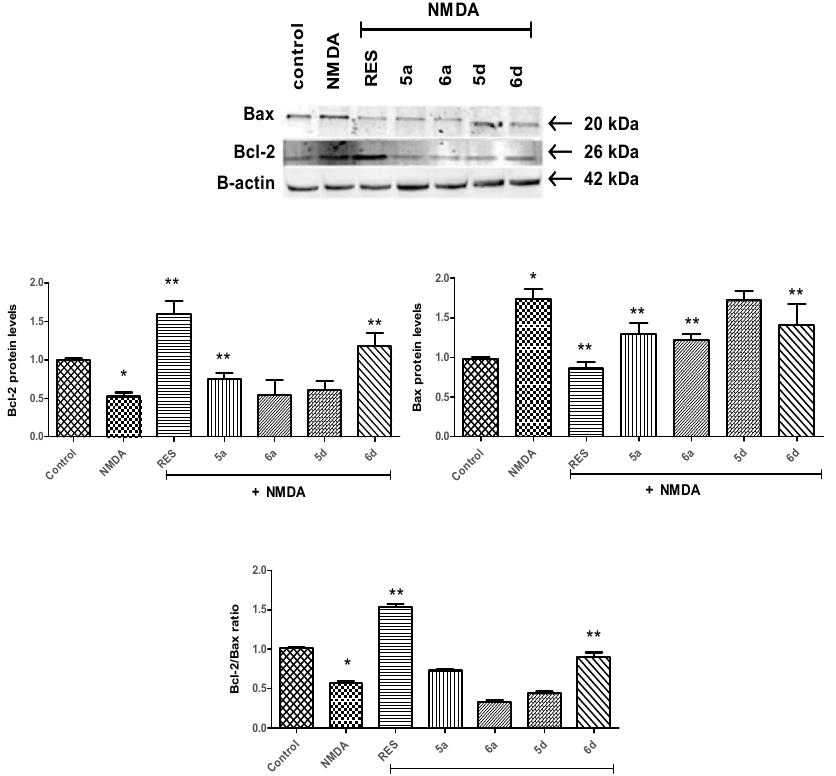
Figure 2. The alteration in Bax and Bcl-2 protein levels following 0.1 µ M triazolo-tomentosin deriva- tive treatments in NMDA-treated cells. Quantified band values were normalized to the corresponding β -actin signal. Bar graph data represent the mean ± SD; n = 3 independent experiments. * p < 0.01 significant difference from untreated cells; ** p < 0.001 significant difference from NMDA-treated cells.